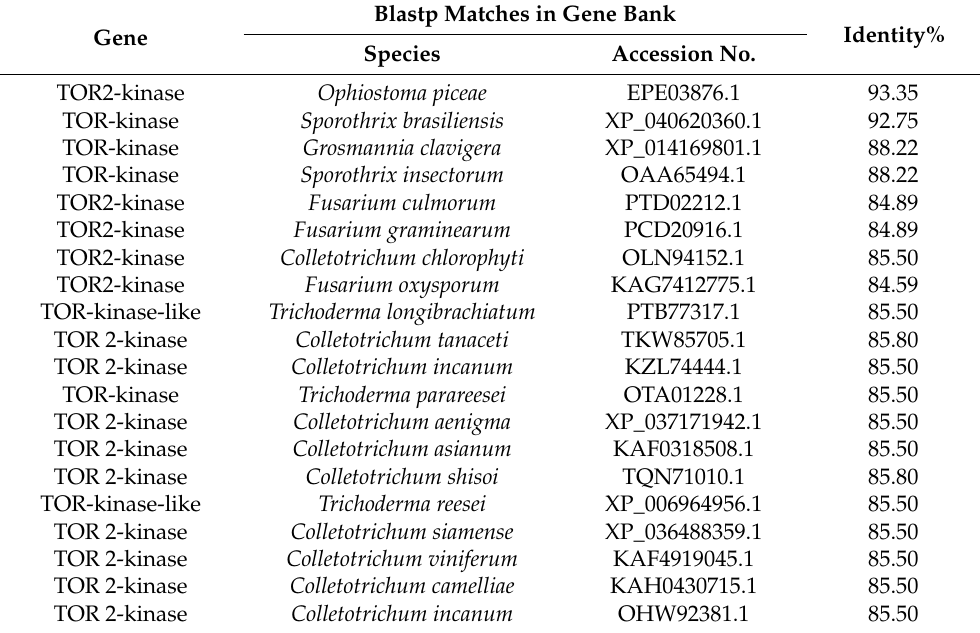
Table 2. Amino acidic identity of the TOR gene from L. qinlingensis , with the relative sequences in other fungi.